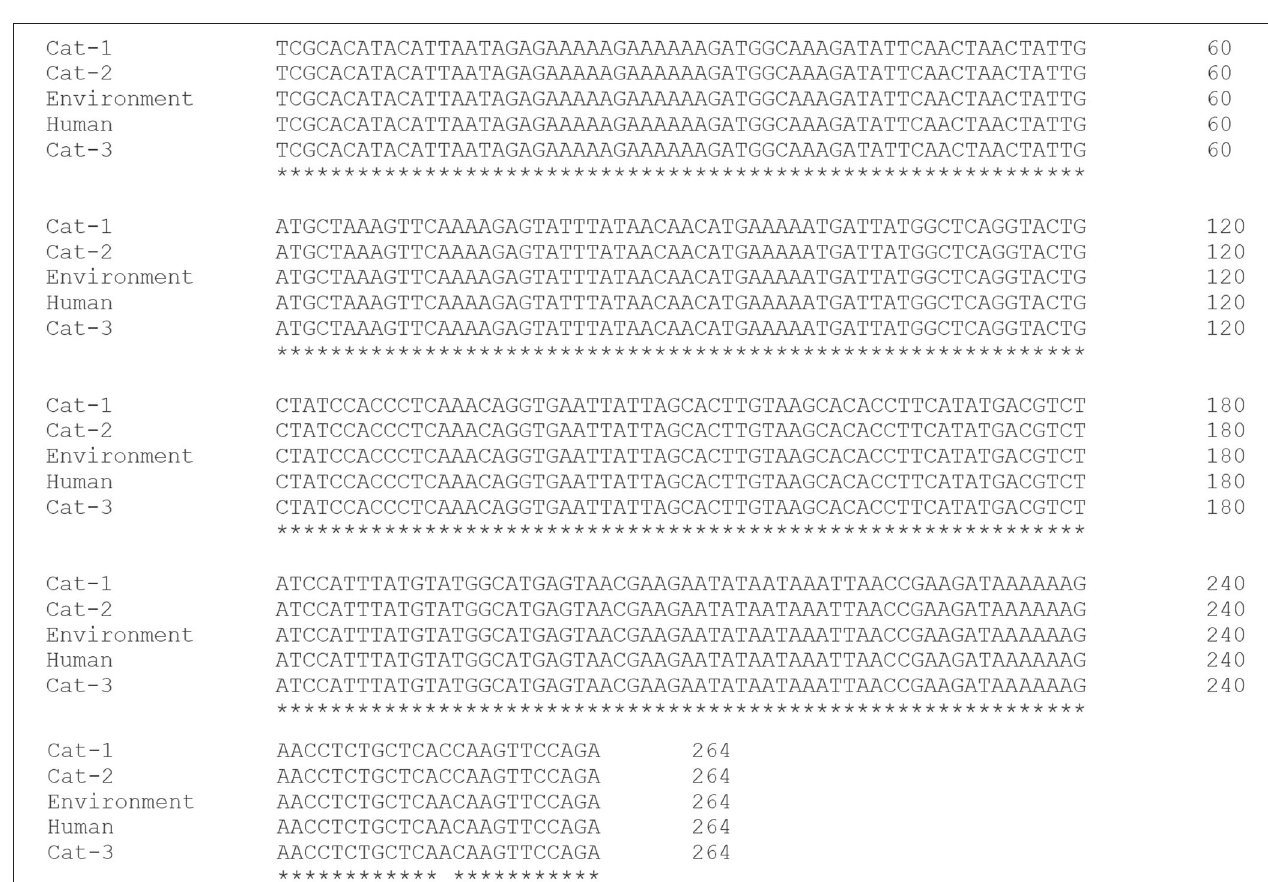
FIGURE 3 | Alignment of Staphylococcus aureus mecA gene (Cat-1, Cat-2, Cat-3, Environmental, and Human sequence).